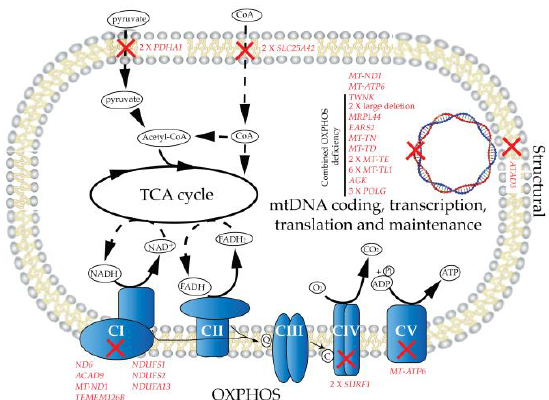
Figure 1. Mutational mapping. Genetic changes (red) of primary mitochondrial disease (PMD) patients reported in this study mapping to the mitochondrial systems of: primary OXPHOS, TCA cycle connections, the mtDNA system, and structural components. Abbreviations: OXPHOS CI–V, oxidative phosphorylation complexes I–V; TCA, tricarboxylic acid cycle.